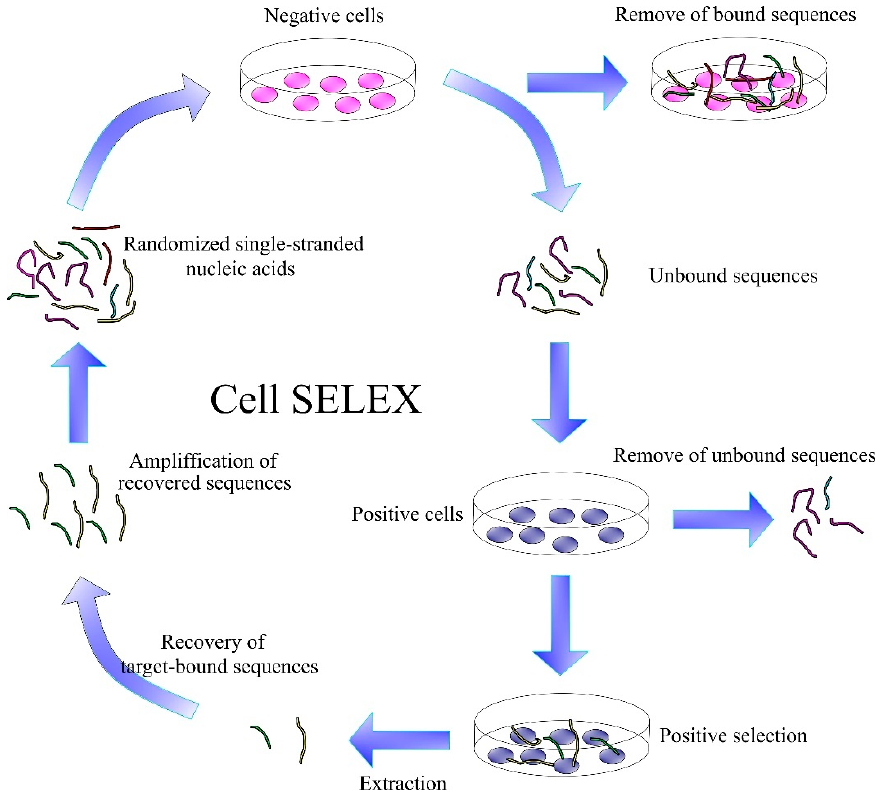
Figure 8. Scheme of the Cell SELEX.